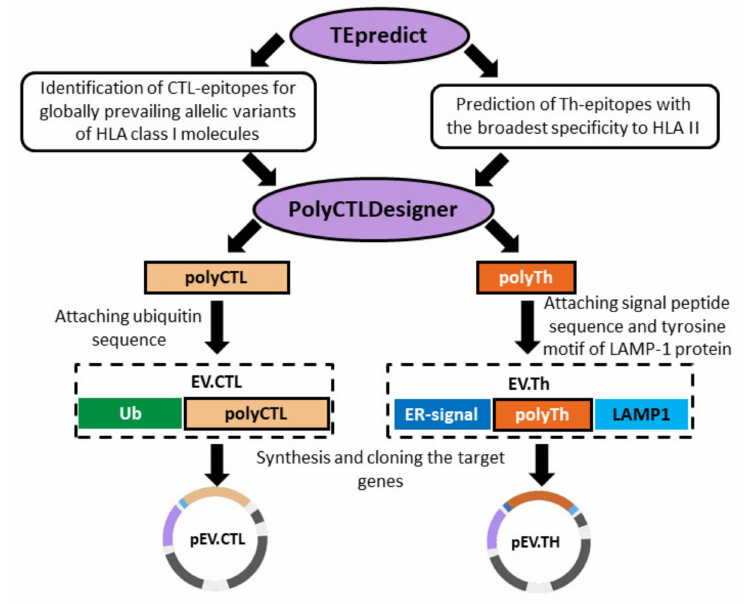
Figure 1. Design of artificial polyepitope Ebola virus (EBOV) immunogens EV.CTL and